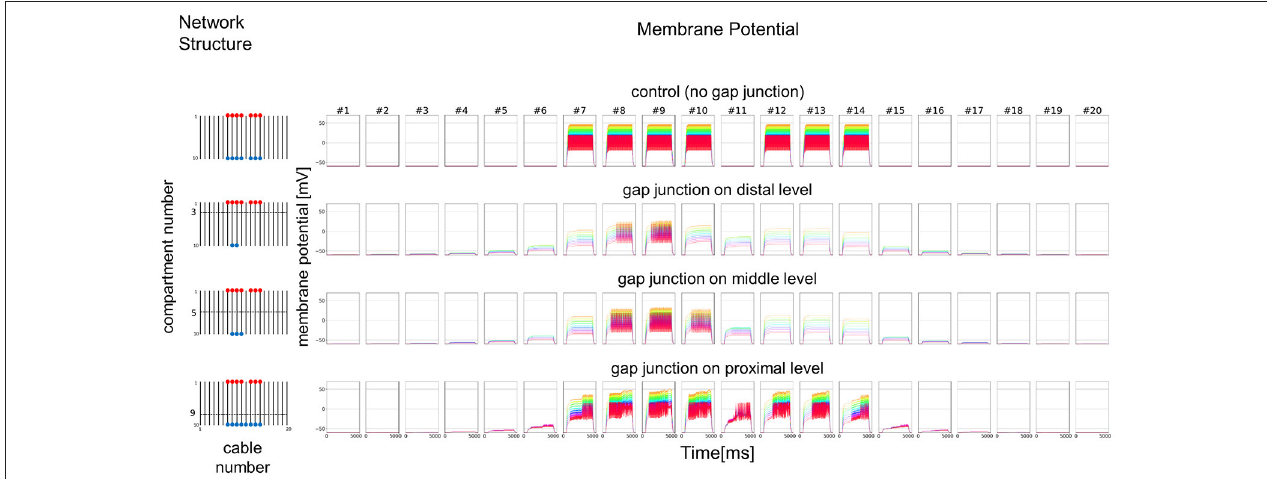
FIGURE 9 | Simplified model with double number of cables and functional simulation with a strong stimulation. Simulation results using multi-compartment model consisting of 20 cables with mutual connections via GJs. Four cases with different patterns of GJs are considered in the same model as Figure 7 . The stimulation with the same amplitude as in Figure 7 is